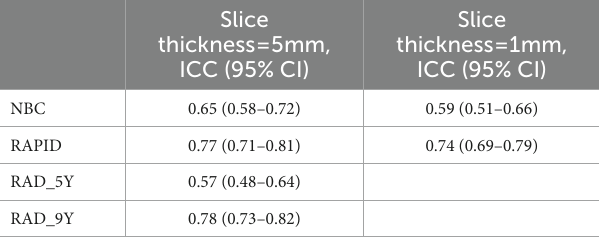
TABLE 2 Agreement between baseline ASPECTS and reference